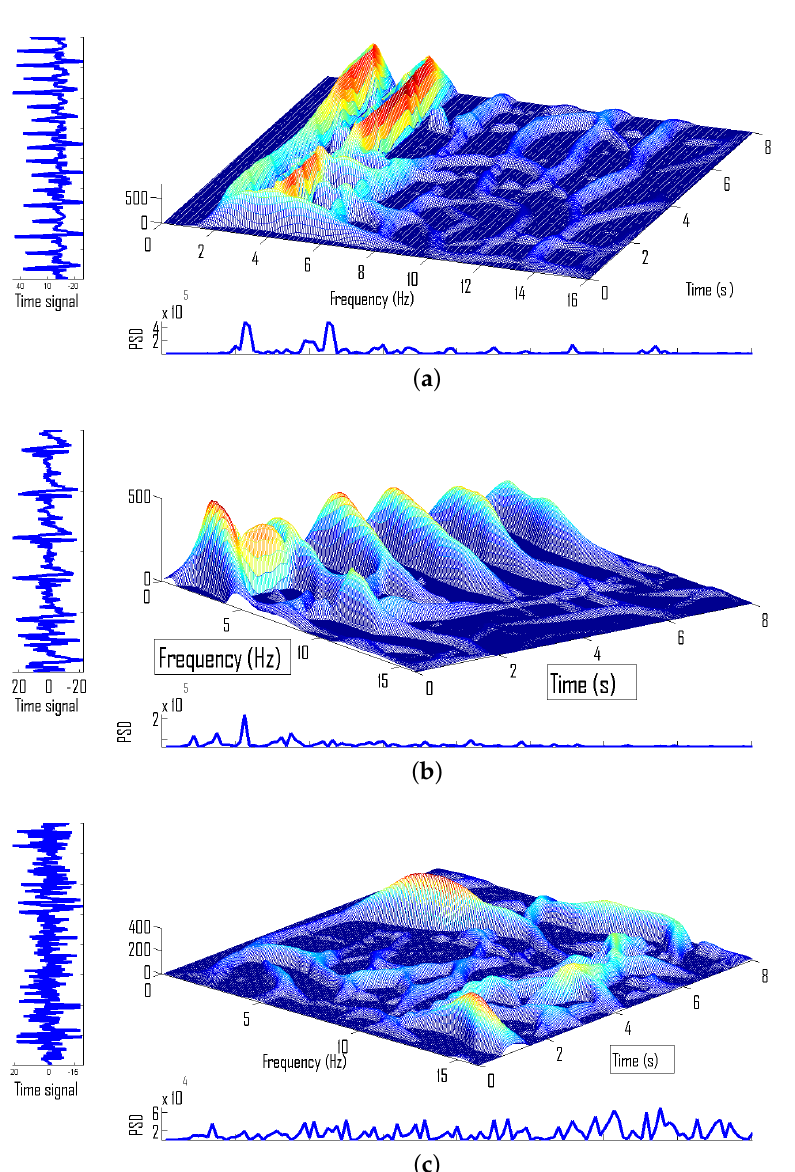
Figure 2. ( a ) EEG seizure composed of frequency modulated chirps, ( b ) EEG seizure composed of spike, ( c ) EEG